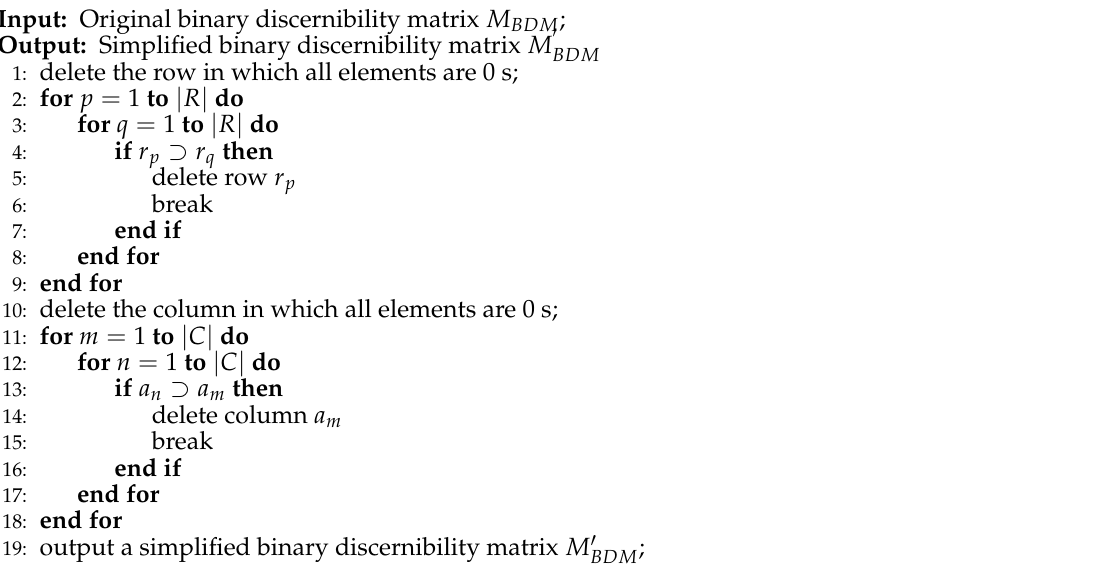
Algorithm 1 : An algorithm of binary discernibility matrix reduction, BDMR